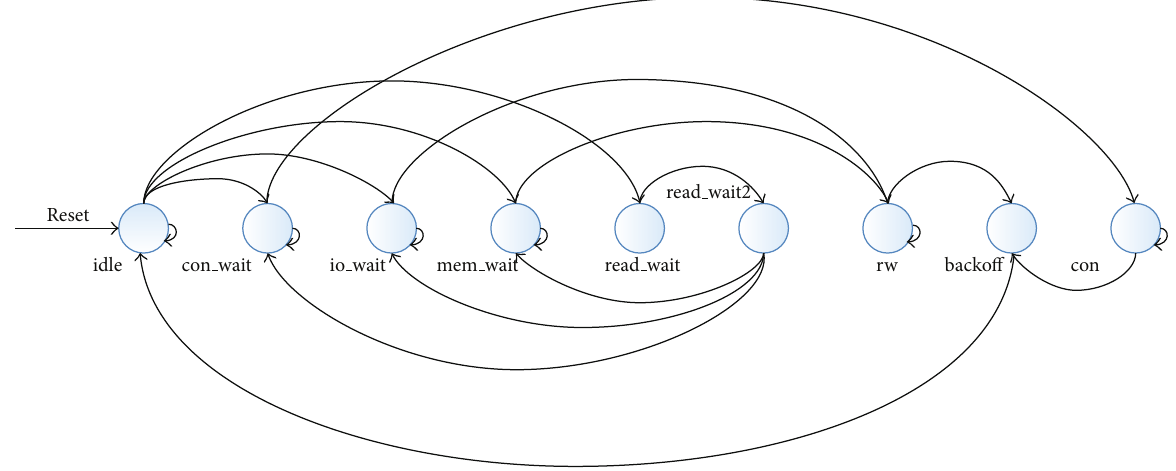
Figure 2: State transition of the PCI protocol decoding